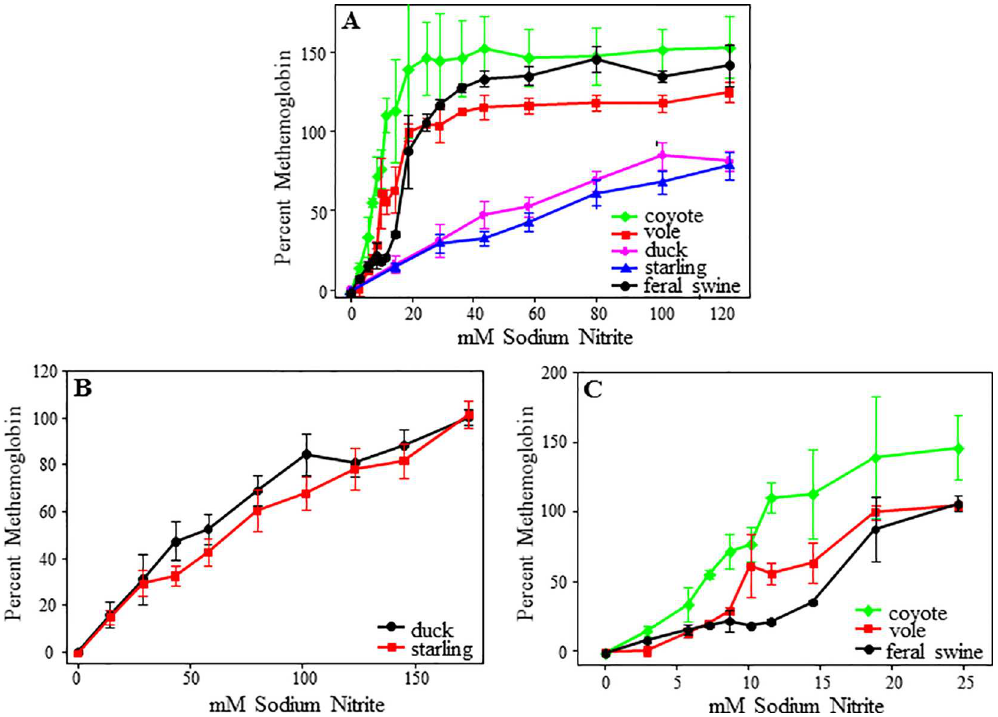
Fig 2. Methemoglobin levels in blood samples exposed to increasing concentrations of sodium nitrite. (A) All species, (B) Avian blood samples, and (C) Mammalianblood samples.The data reportedare the initial post KCN additionopticaldensitiesand represent the averageof 3 (mammals), 4 (duck), or 9 (starlings) independentblood samples exposedto PBS or sodium nitrite. Error bars correspondto the standard errors of the means.